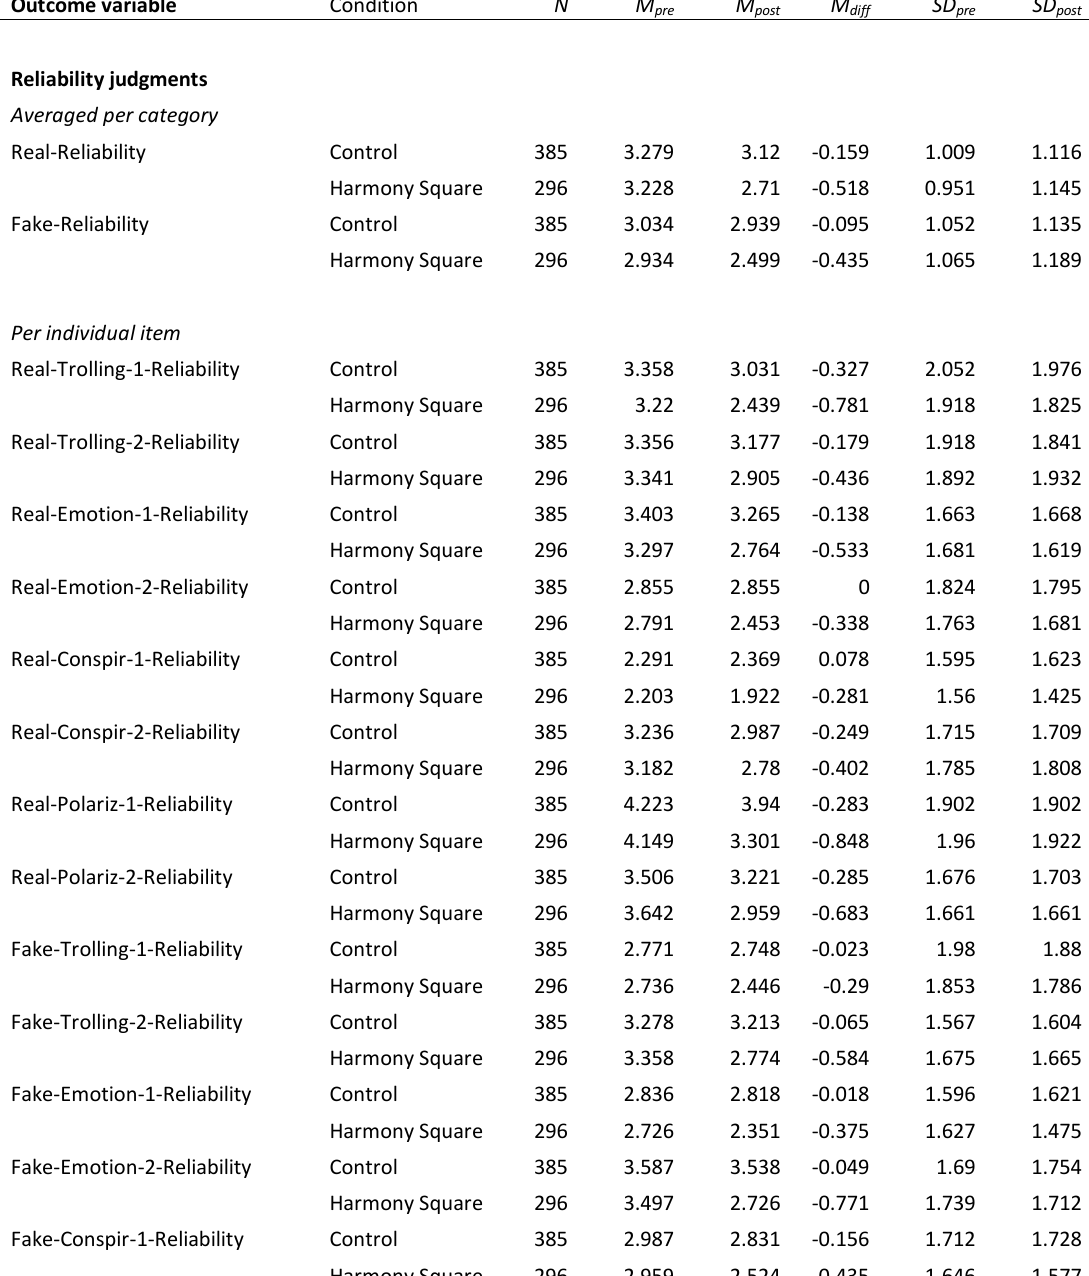
Appendix: Table S2: Descriptive statistics for social media posts (items), per outcome variable, averaged and by